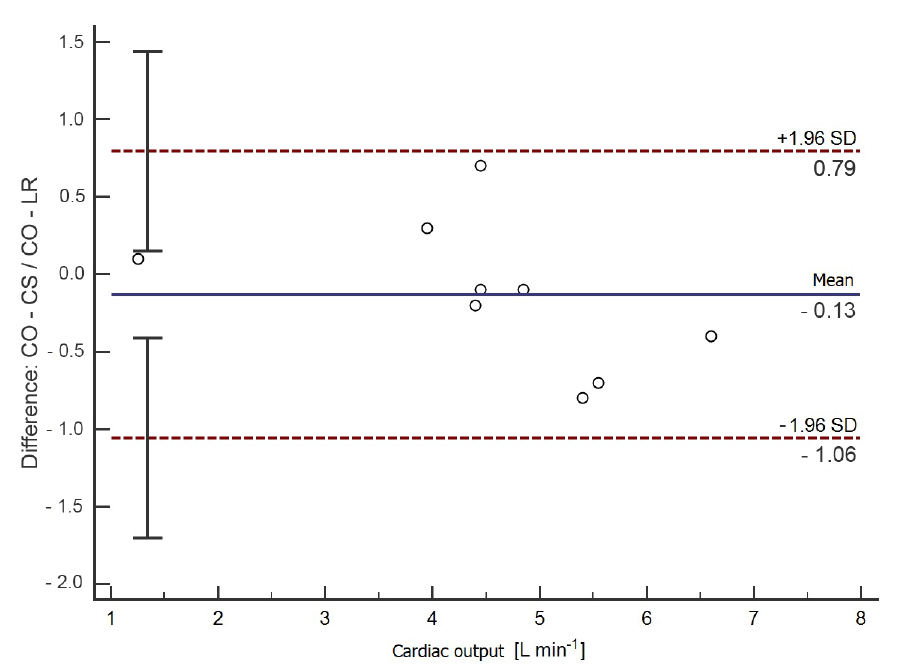
Figure 3. Bland–Altman analysis for the calculated CO-LR and CO-CS values in the group of patients with a visible dicrotic notch on the pulse wave curve ( n = 9). The solid horizontal line represents the mean value difference between the methods tested. The upper dashed line shows the upper compliance limit value (+1.96 SD). The lower dashed line shows the value of the lower compliance limit ( − 1.96 SD); SD—standard deviation.